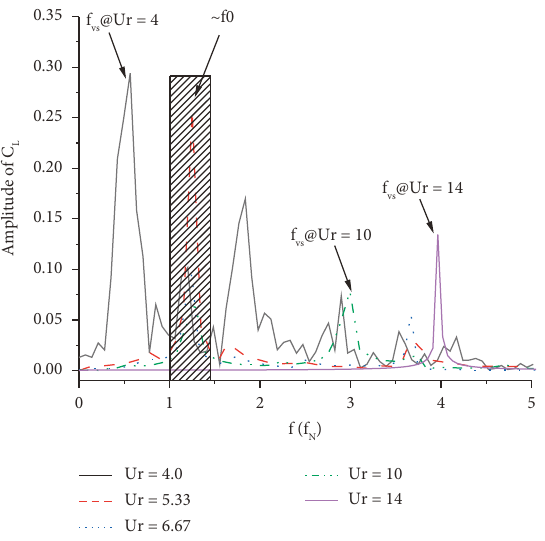
Figure 7: Spectra of lift